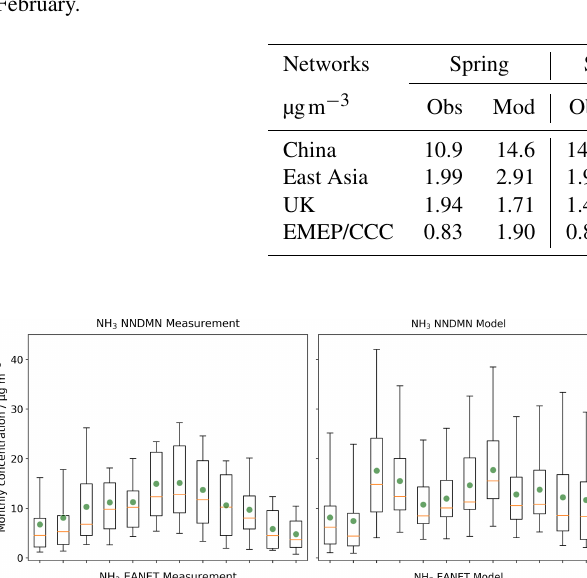
Table 5. Seasonal averages of monthly NH 3 concentrations (µgm − 3 ) for model (Mod) and measurements (Obs) in four monitoring networks: